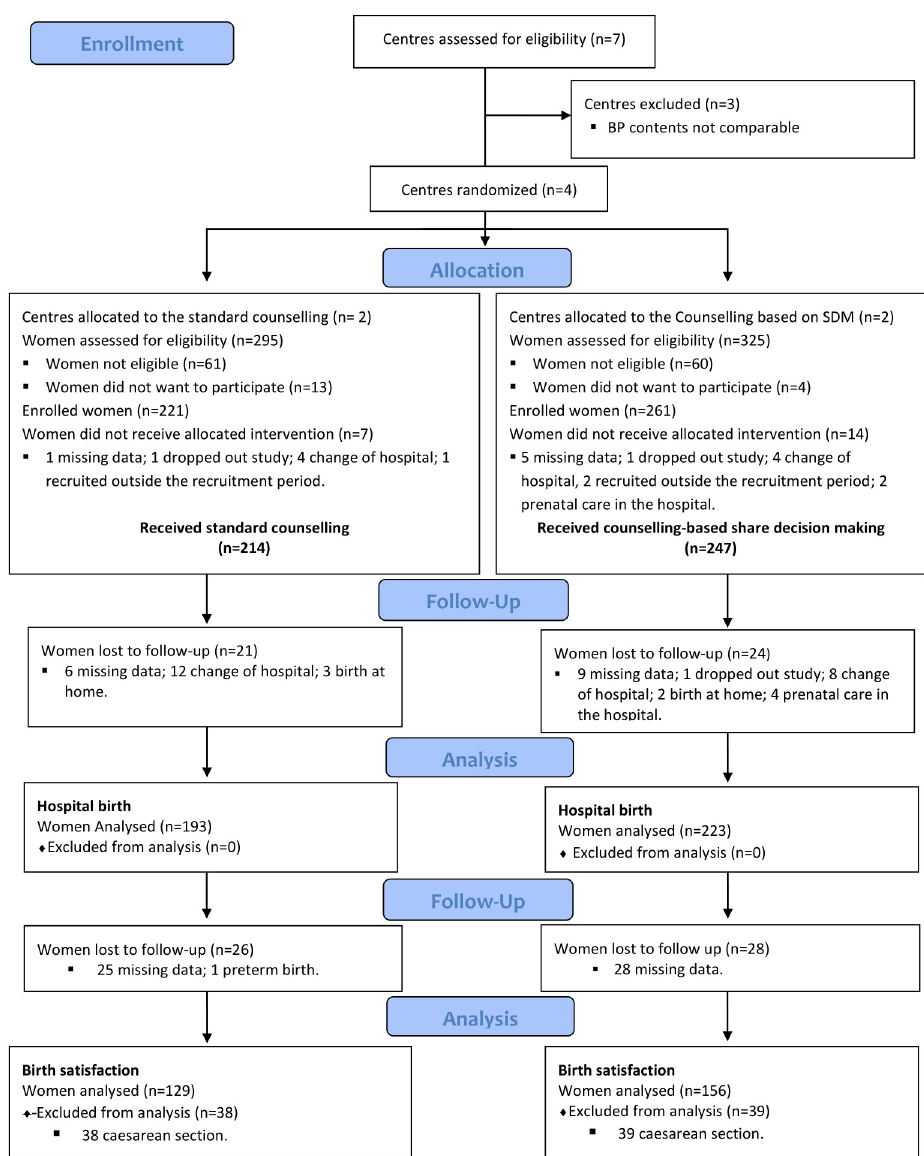
Fig 2. Flowchart of clusters and participants, inclusion, exclusion, and losses to follow-up. SDM: Shared decision making.